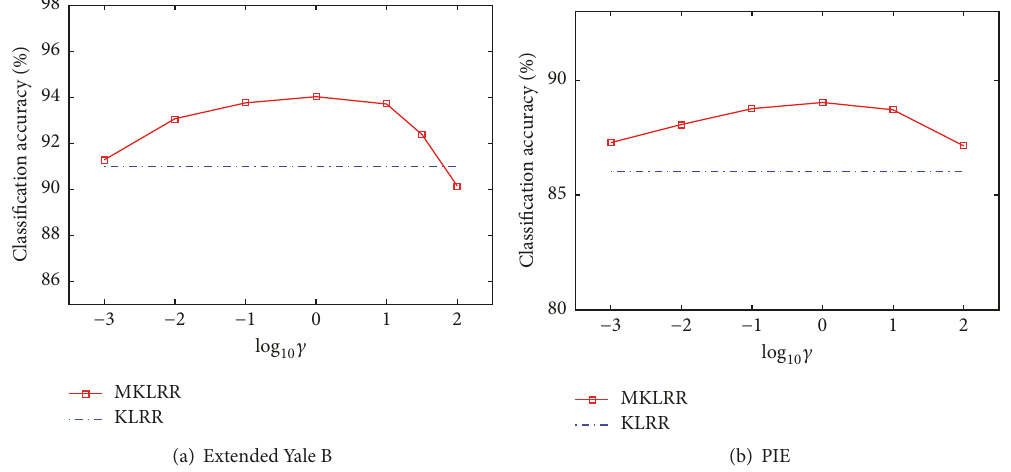
Figure 7: The performance of MKLRR versus parameter 𝛾 by fixing 𝜆 = 1 .